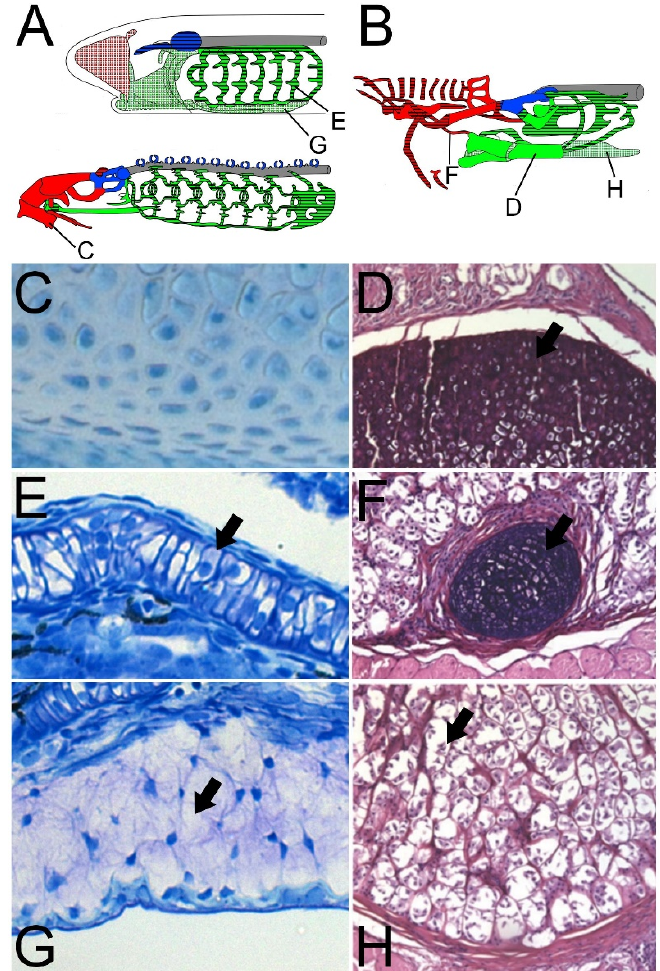
Figure 2. Variants of cartilage in cyclostomes. ( A ) Lamprey ammocoete (top) and adult lamprey (bottom). ( B ) Adult hagfish. Letters correspond with their respective panels. ( C ) Hard cartilage from adult lamprey annular cartilage. ( D ) Hard cartilage from adult hagfish medial basal plate. Both hard cartilages are surrounded by abundant ECM. ( E ) Soft cartilage from lamprey ammocoete branchial arch. ( F ) Soft cartilage from adult hagfish lateral tentacular cartilages. Both soft cartilages are compact and have sparse ECM. ( G ) Mucocartilage from lamprey ammocoete ventral pharynx. ( H ) Pseudo-cartilage from adult hagfish posterior basal plate. Both cartilage-like tissues have fibroblast-like morphology with cartilage features. Panels D, F, and H were reproduced via Miyashita (2012) with permission from Tetsuto Miyashita.